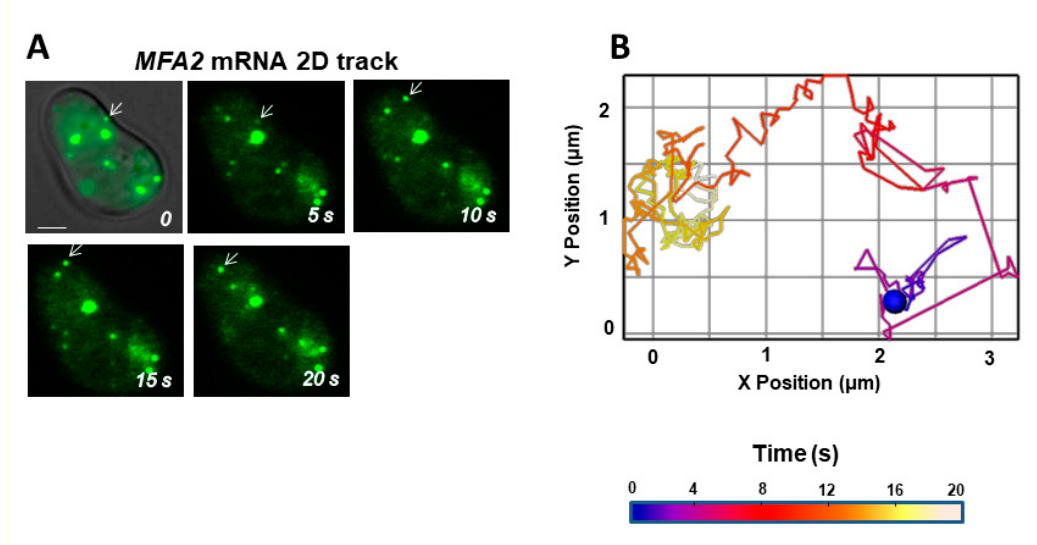
Figure 3. High time resolution tracking in 2D revealed extensive MFA2 granule movement. ( A ) Cells expressing mRNA (green) treated with α -factor for 2 h were examined by fluorescence microscopy. There was a rudimentary shmoo on the upper left side of the cell. White arrow indicates the motile, low intensity mRNA transport granule analyzed in ( B ). Scale bar = 2 µm. ( B ) Over most of its journey, the granule changed directions incessantly and took a very indirect route to the shmoo. The color scale refers to the time. Track displacement rate was 0.01 µm/s. Mean velocity was 0.73 µm/s.